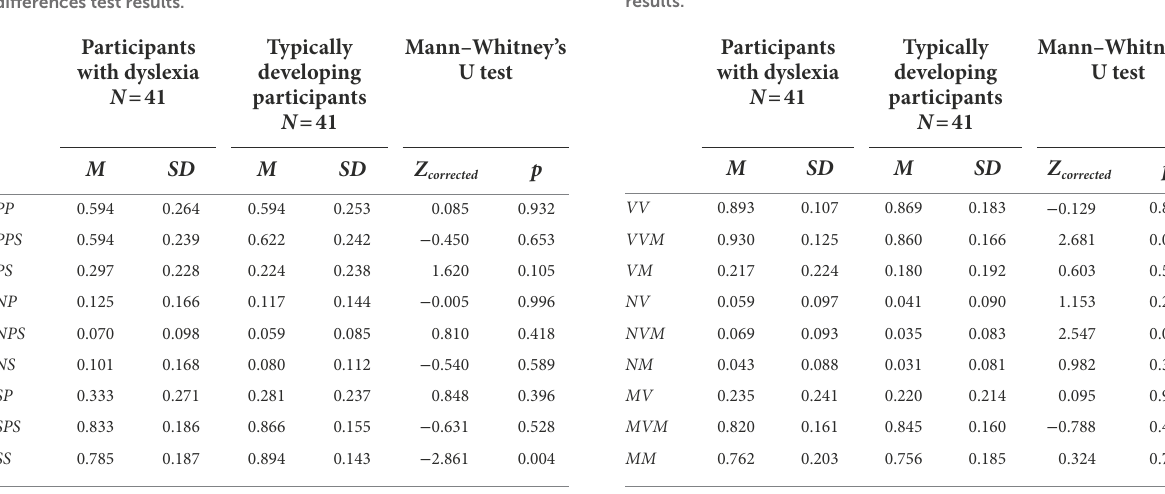
TABLE 3 Descriptive statistics for the probability of a “yes” answer in different test conditions for the pictorial material and differences test